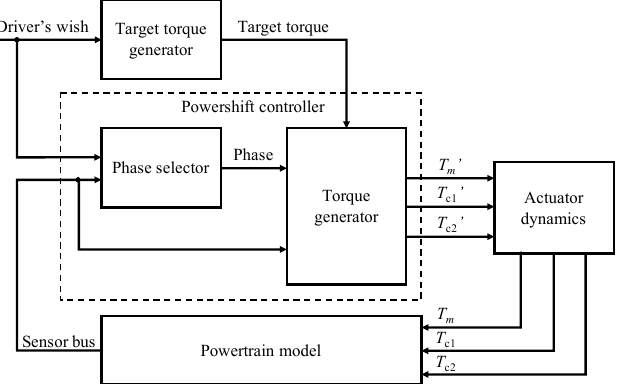
Figure 3. Power shift controller